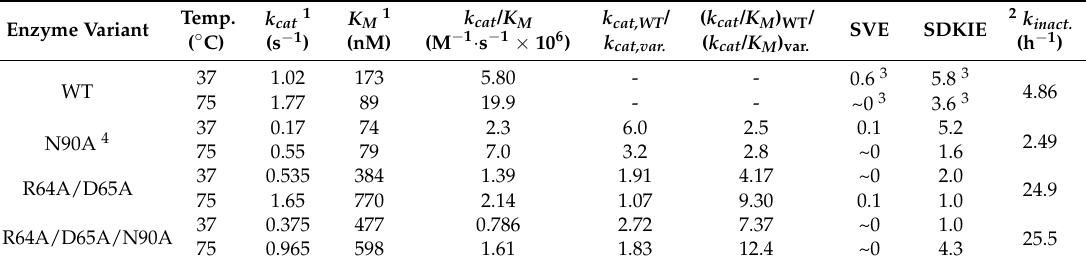
Table 1. Steady-state kinetic parameters for β 1 α 1 loop